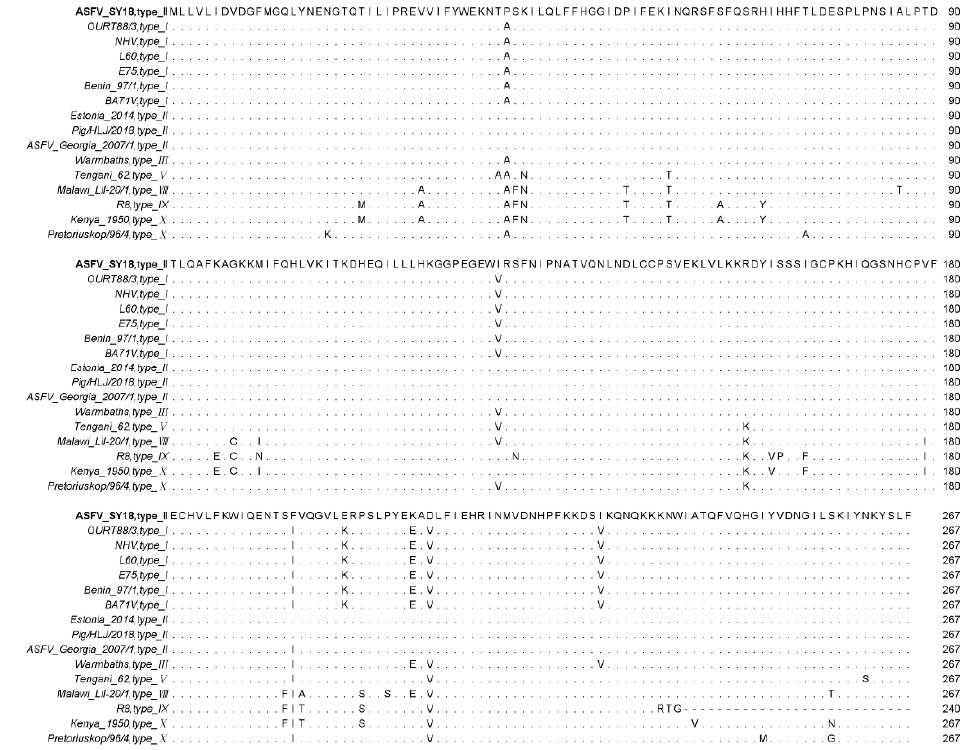
Figure 1. Multiple sequence alignment of ASFV pI267L amino acids residues. In multiple sequence alignment, the same amino acids are displayed by ‘.’, the absence of amino acids are displayed by ‘-’, and the differential amino acids are displayed by abbreviated letters of amino acids.